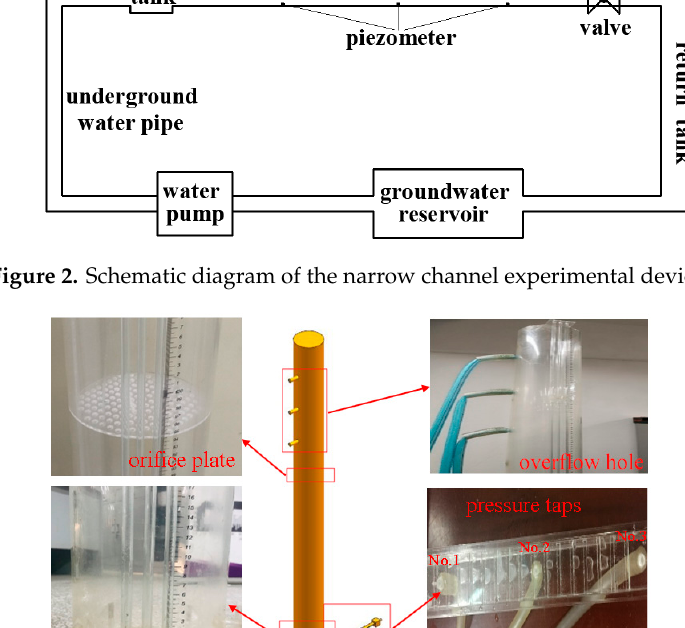
Figure 3. Detailed diagram of the tank and narrow channel.